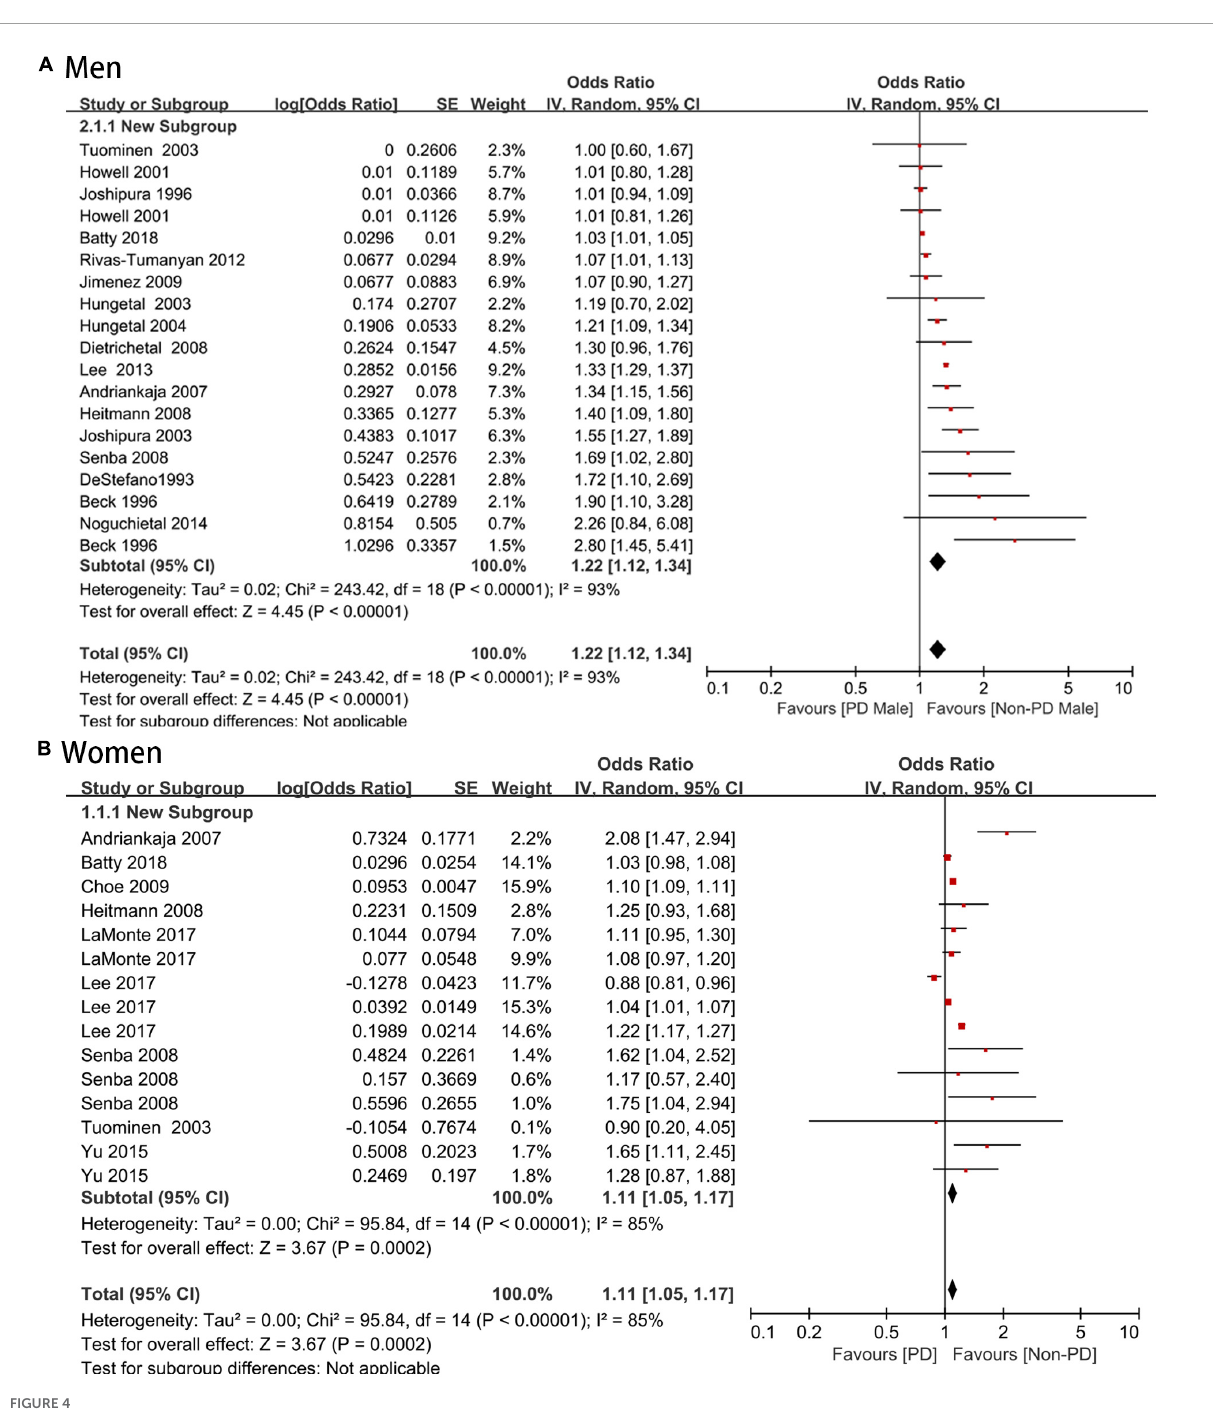
differences were shown in the coronary artery disease subgroup analysis, where men with periodontal disease had a higher risk of coronary artery disease than in women. In addition, a prospective cohort showed that the incidence of stroke in men was significantly higher than that in women in the total population and among the periodontal disease groups (56). This may arise from the expression of Y-encoded genes and the lack of cardiovascular protective effects of estrogen, leading to male-specific cardiovascular events.